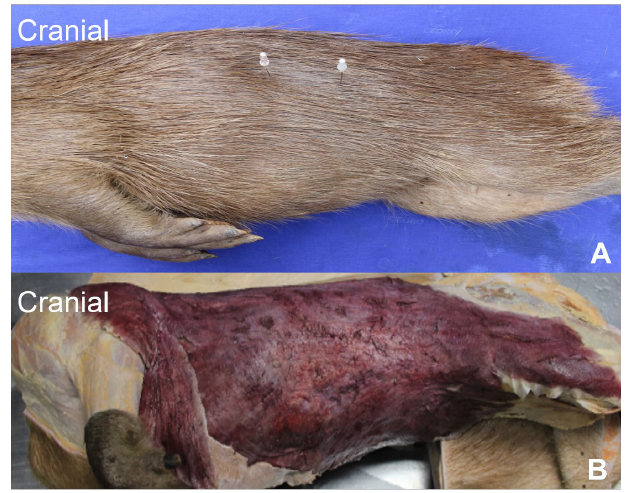
Figure 1. ( A ). Region of dissection of the lateral abdomen (between needles). ( B ). Cutaneous muscle highlighted with hibiscus ink.